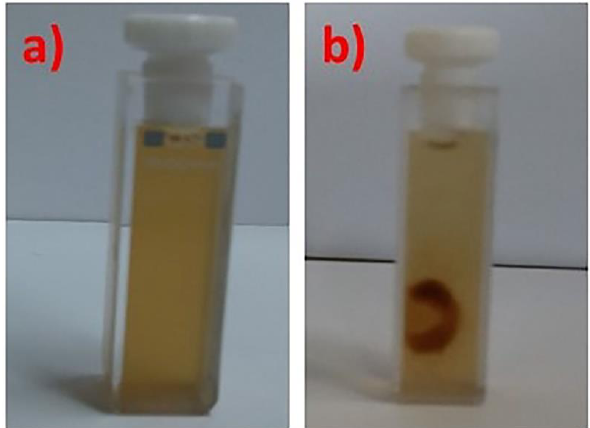
Figure 3. PLMA 22 - b -POEGMA 13 /10% NPs mixed solution before ( a ) and after ( b ) the application of magnetic field (using a magnet) for the magnetophoresis experiments.